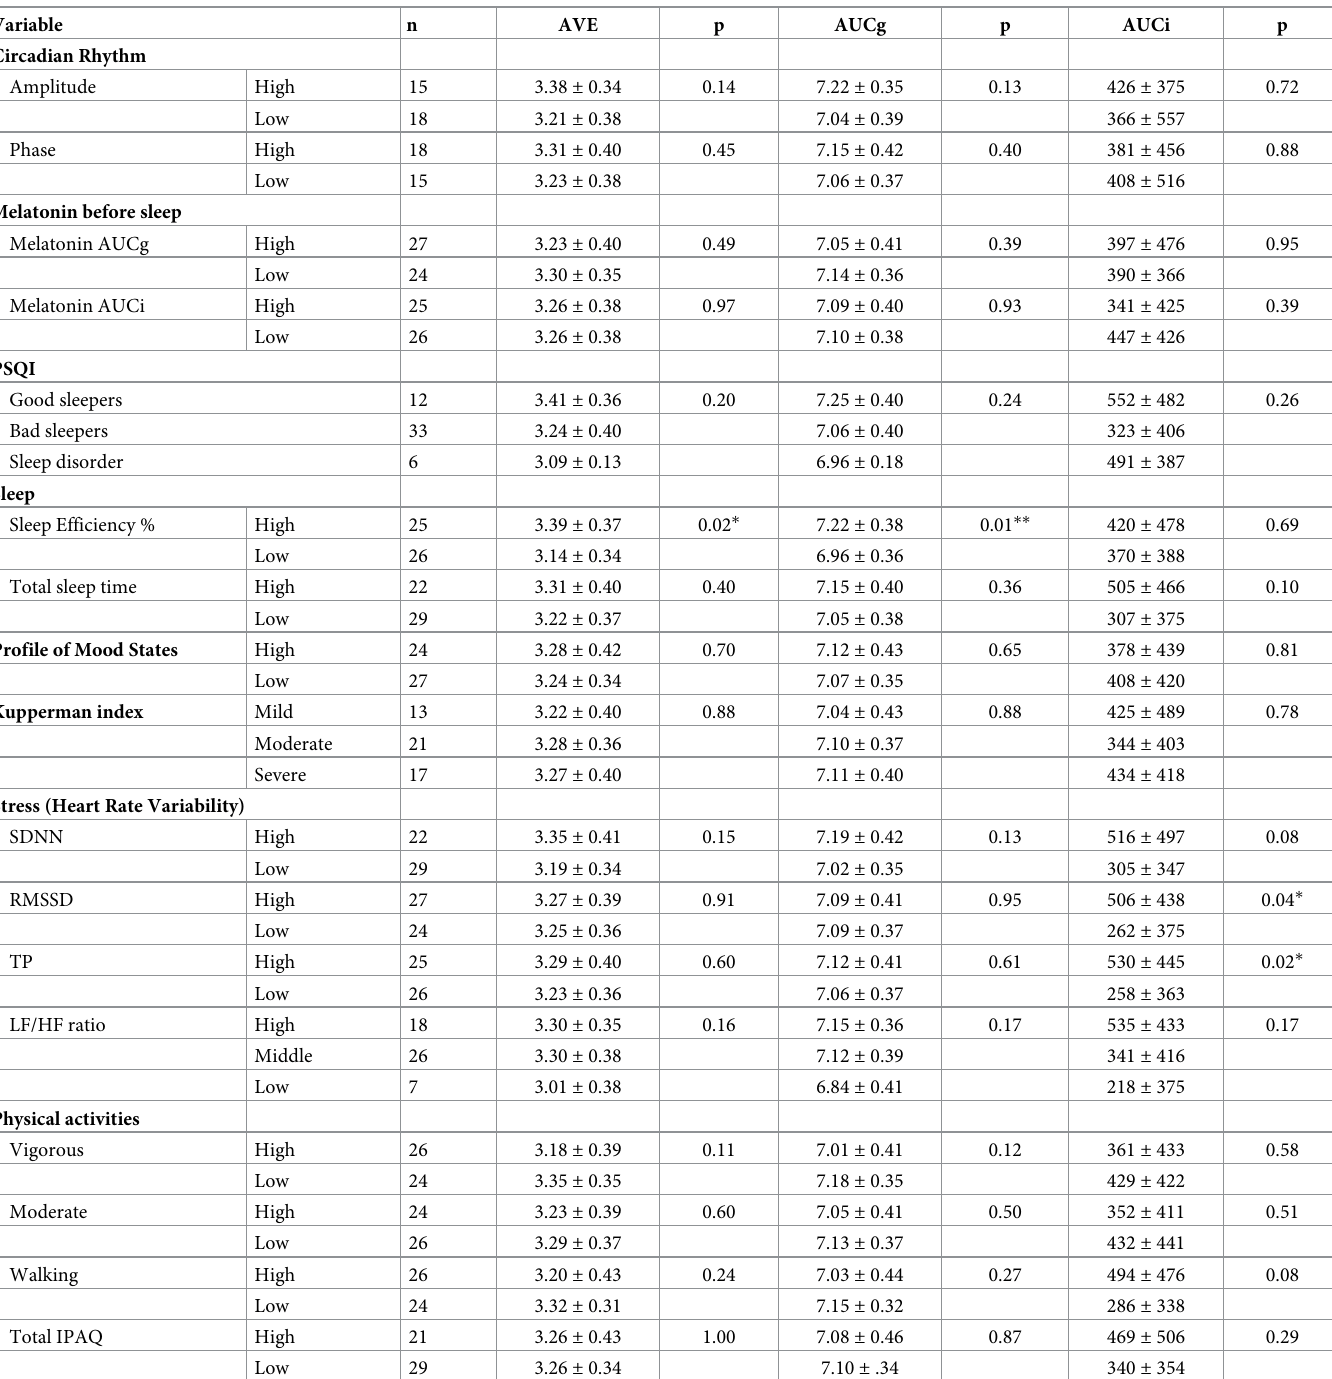
Table 2. Differences in CAR based on multiple variables including circadian rhythms, sleep, stress, and physical activities before the program. Variable n